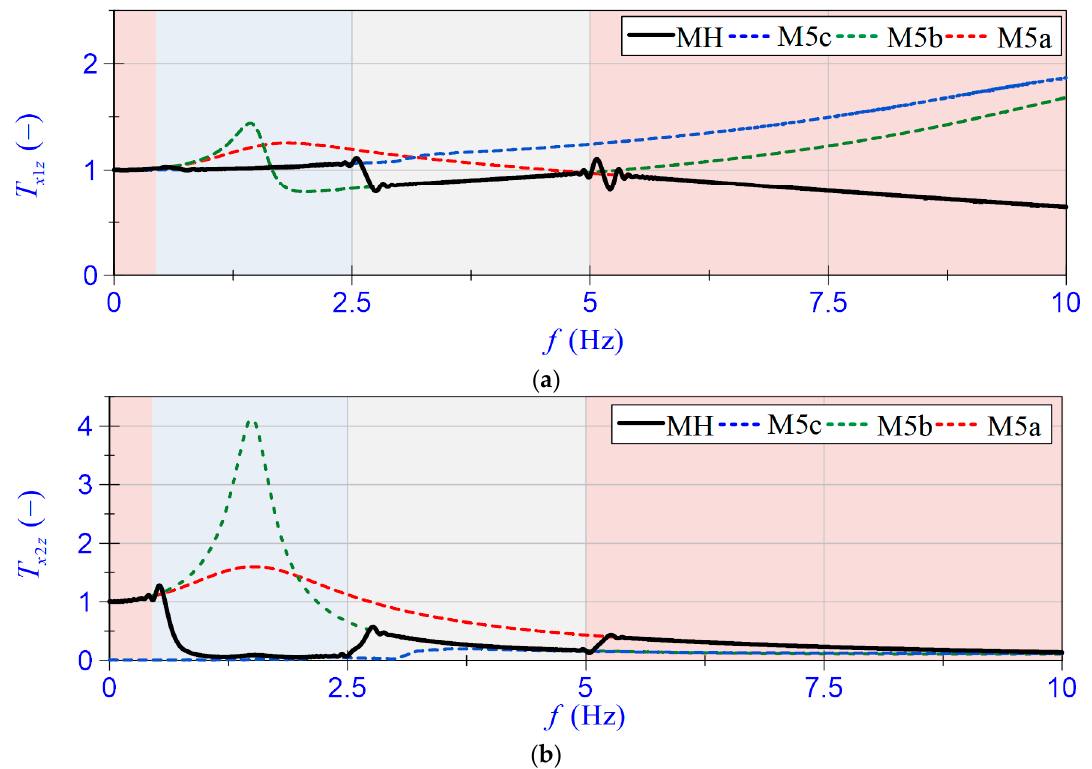
Figure 9. Displacement transmissibility coefficients: ( a ) T x 1 z ; ( b ) T x 2 z —HVRS.